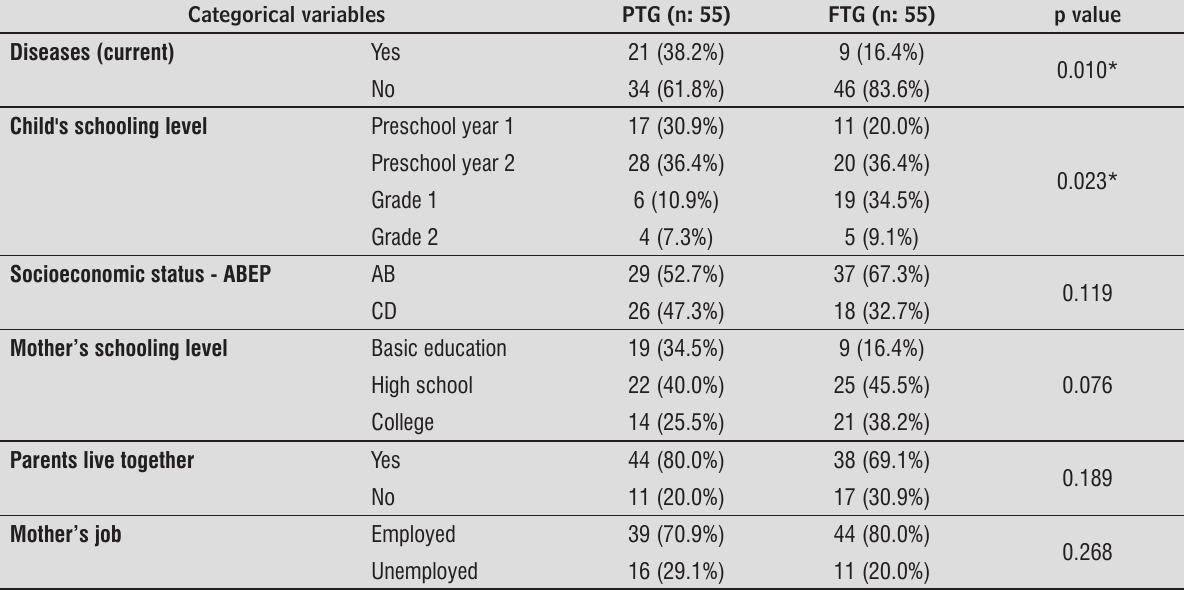
Table 2 - Characteristics of the study participants according to categorical variables Categorical